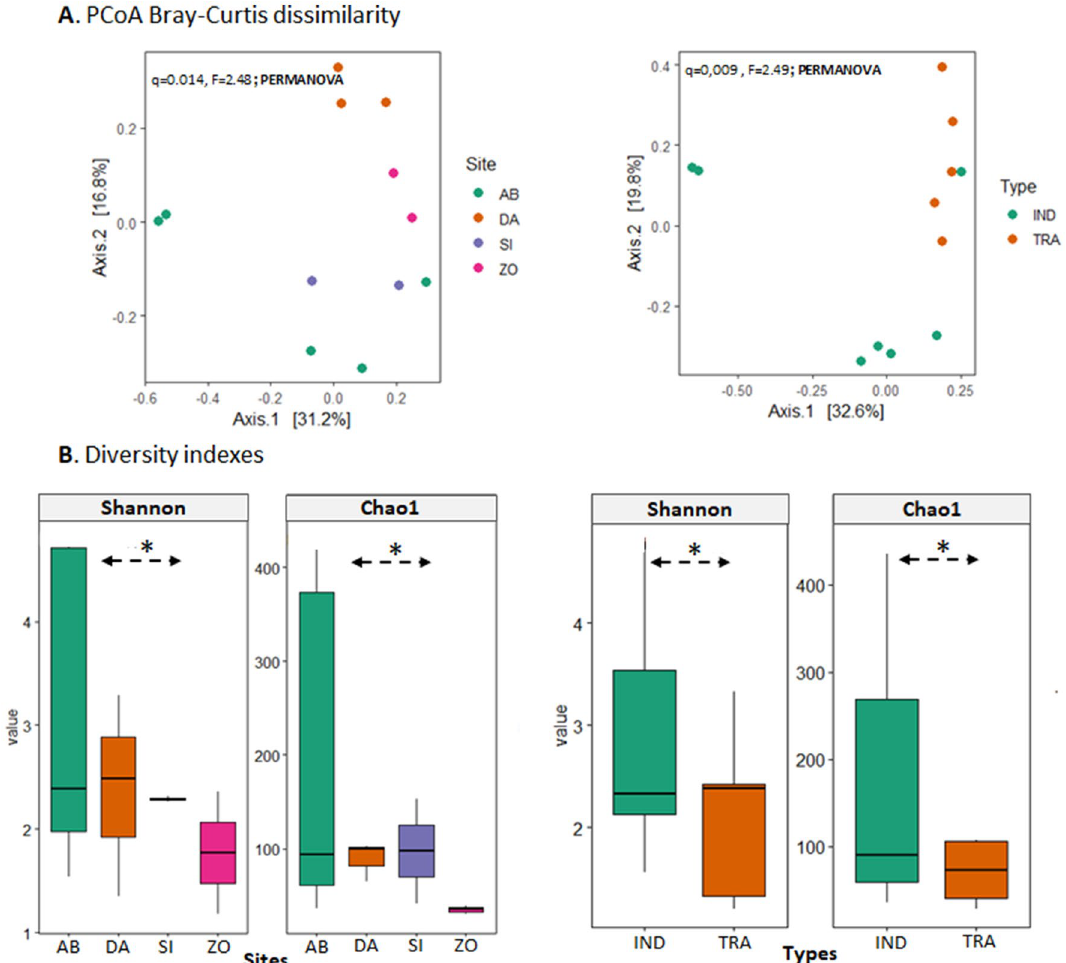
Figure 1. The overall bacterial community structure and diversity of palm oil mill effluents (POME) from Côte d’Ivoire. ( A ) PCoA using Bray–Curtis dissimilarity based on the genus-level ASV shows significant differences between samples based on palm oil processing areas (q = 0.014, F = 2.48, PERMANOVA) and the type of processing (q = 0.009, F = 2.49, PERMANOVA). ( B ) The boxplot shows the existence of similar microbial diversity (Chao richness and Shannon diversity) in the samples according to the area and the type of palm oil processing ( B ). The significance in the difference was calculated by Kruskal–Wallis test. Samples were collected in four distinct localities namely Aboisso (AB), Dabore (DA), Sikensi (SI) and Zouan Houien (ZO) by considering the two type of processing notably industrial (IND) and artisanal